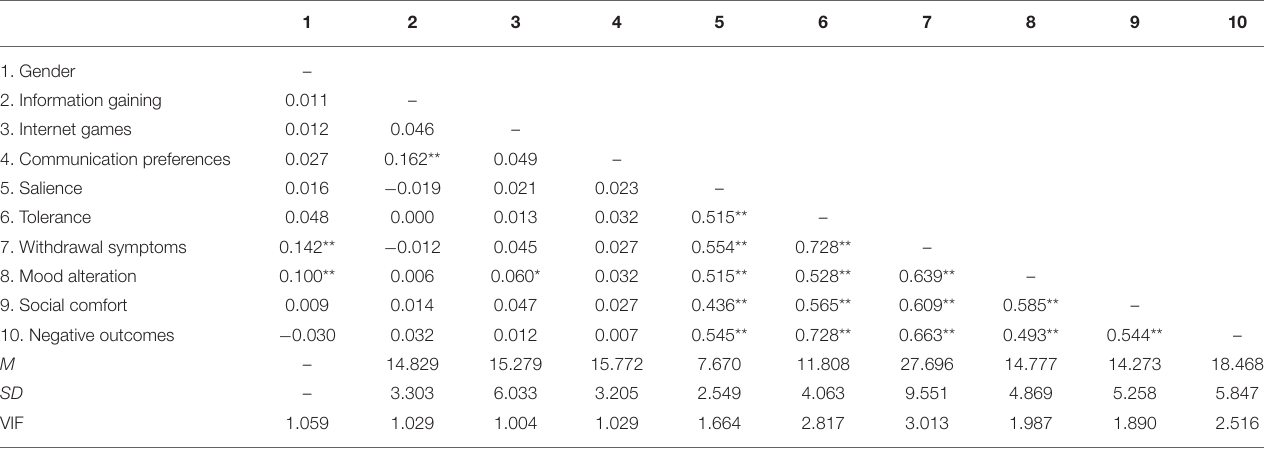
TABLE 1 | Correlation, descriptive statistics, and Variance inflation factor (VIF) for key study variables.